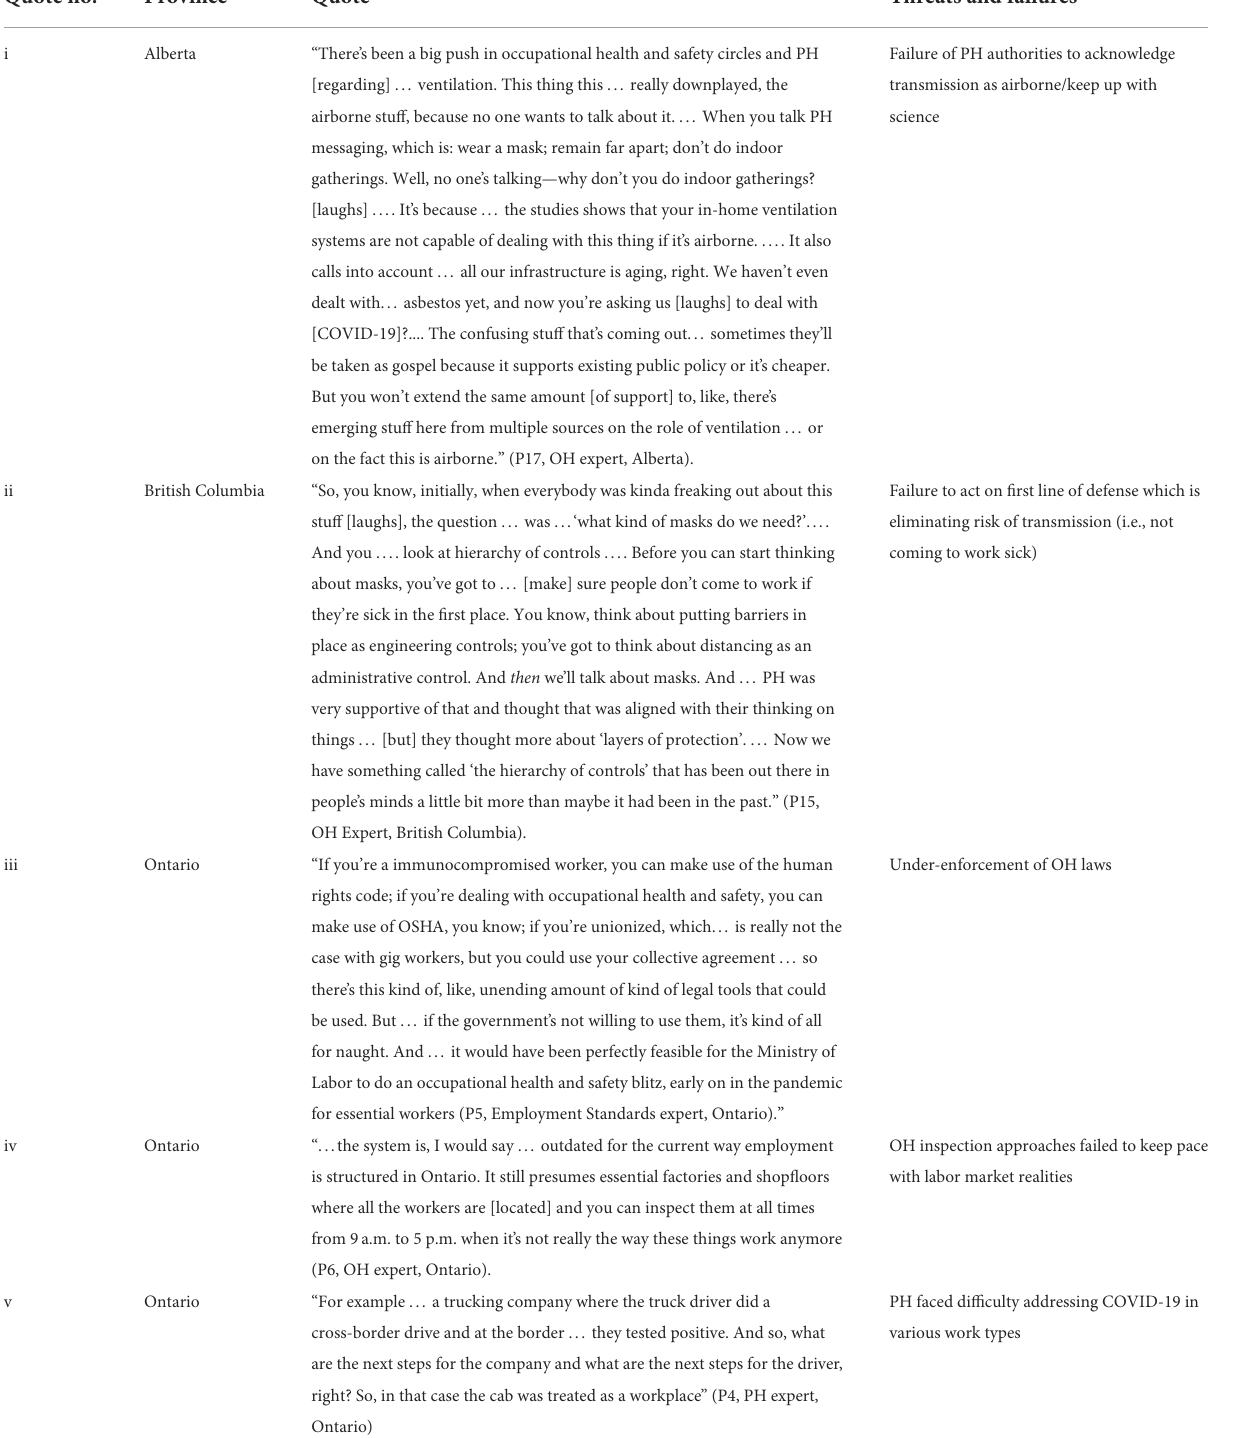
TABLE 6 Threats: Key points identified from quotes about PH-OH pandemic response and KI province. Quote